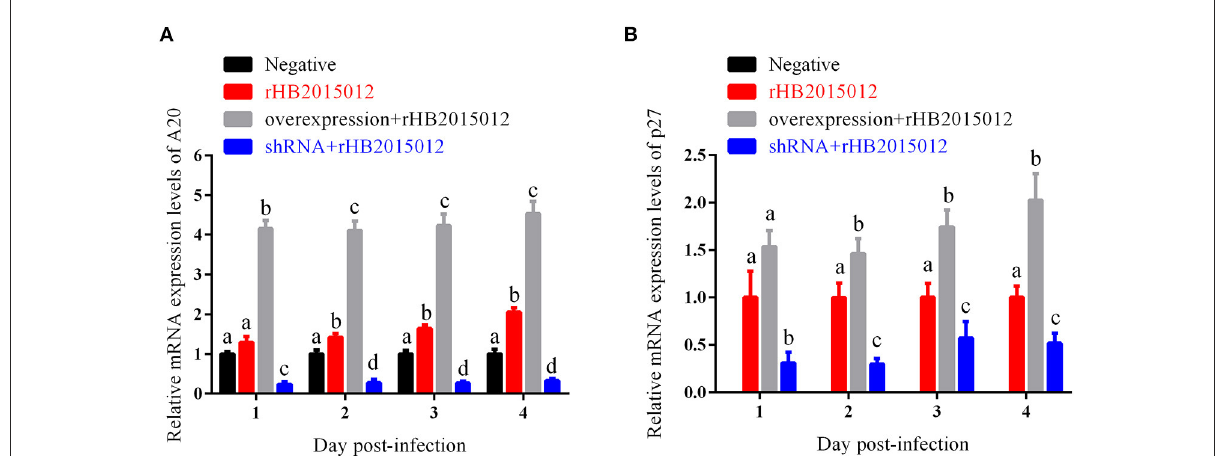
FIGURE3 Effects of A20 on ALV-A rHB2015012 in vitro replication. (A) A20 recombinant adenoviruses capable of overexpressing and interfering with A20 production in DF-1 cells. (B) A20 promotes the replication of ALV-A rHB2015012 in DF-1 cells. a, b, c, and d indicate differences, with the same letter indicating no difference and different letters indicating a difference.